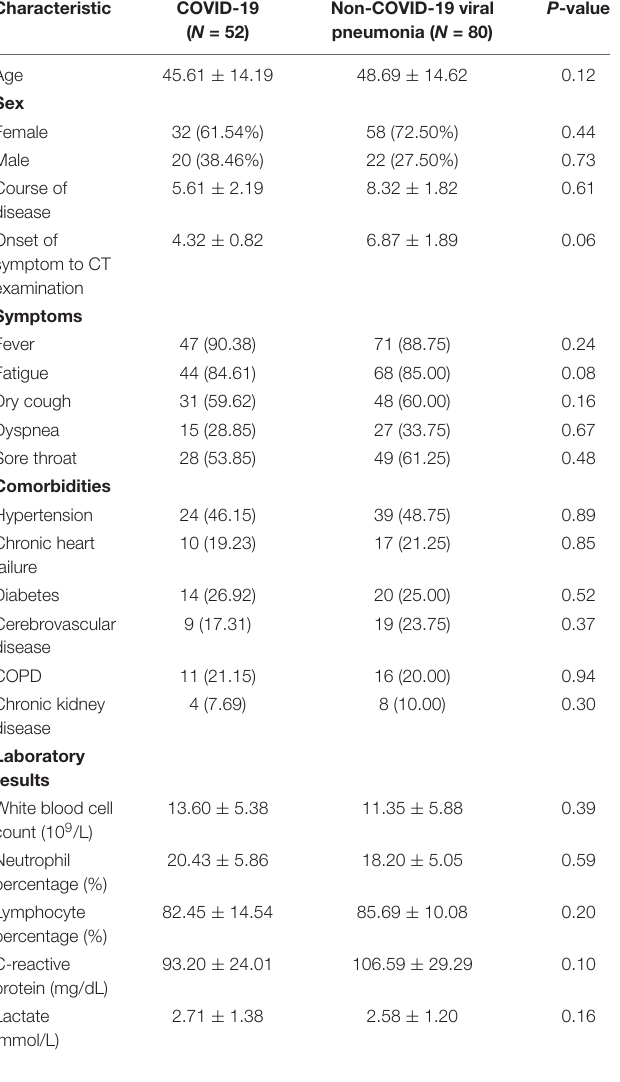
TABLE 1 | Patients characteristics between case and control patients [ n (%)].